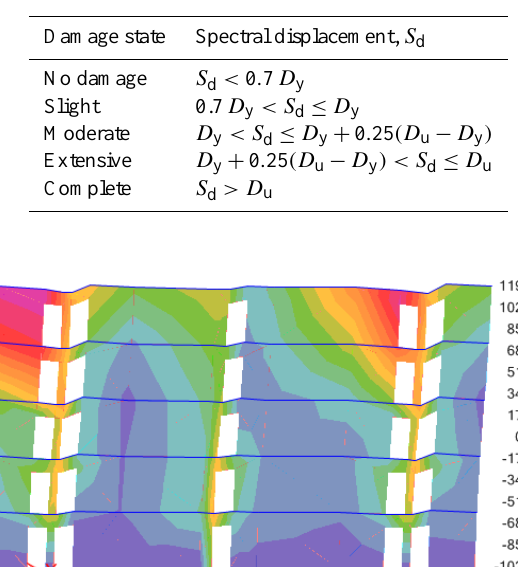
Table 2. Performance levels and criteria provided by Lagomarsino and Penna (2003).